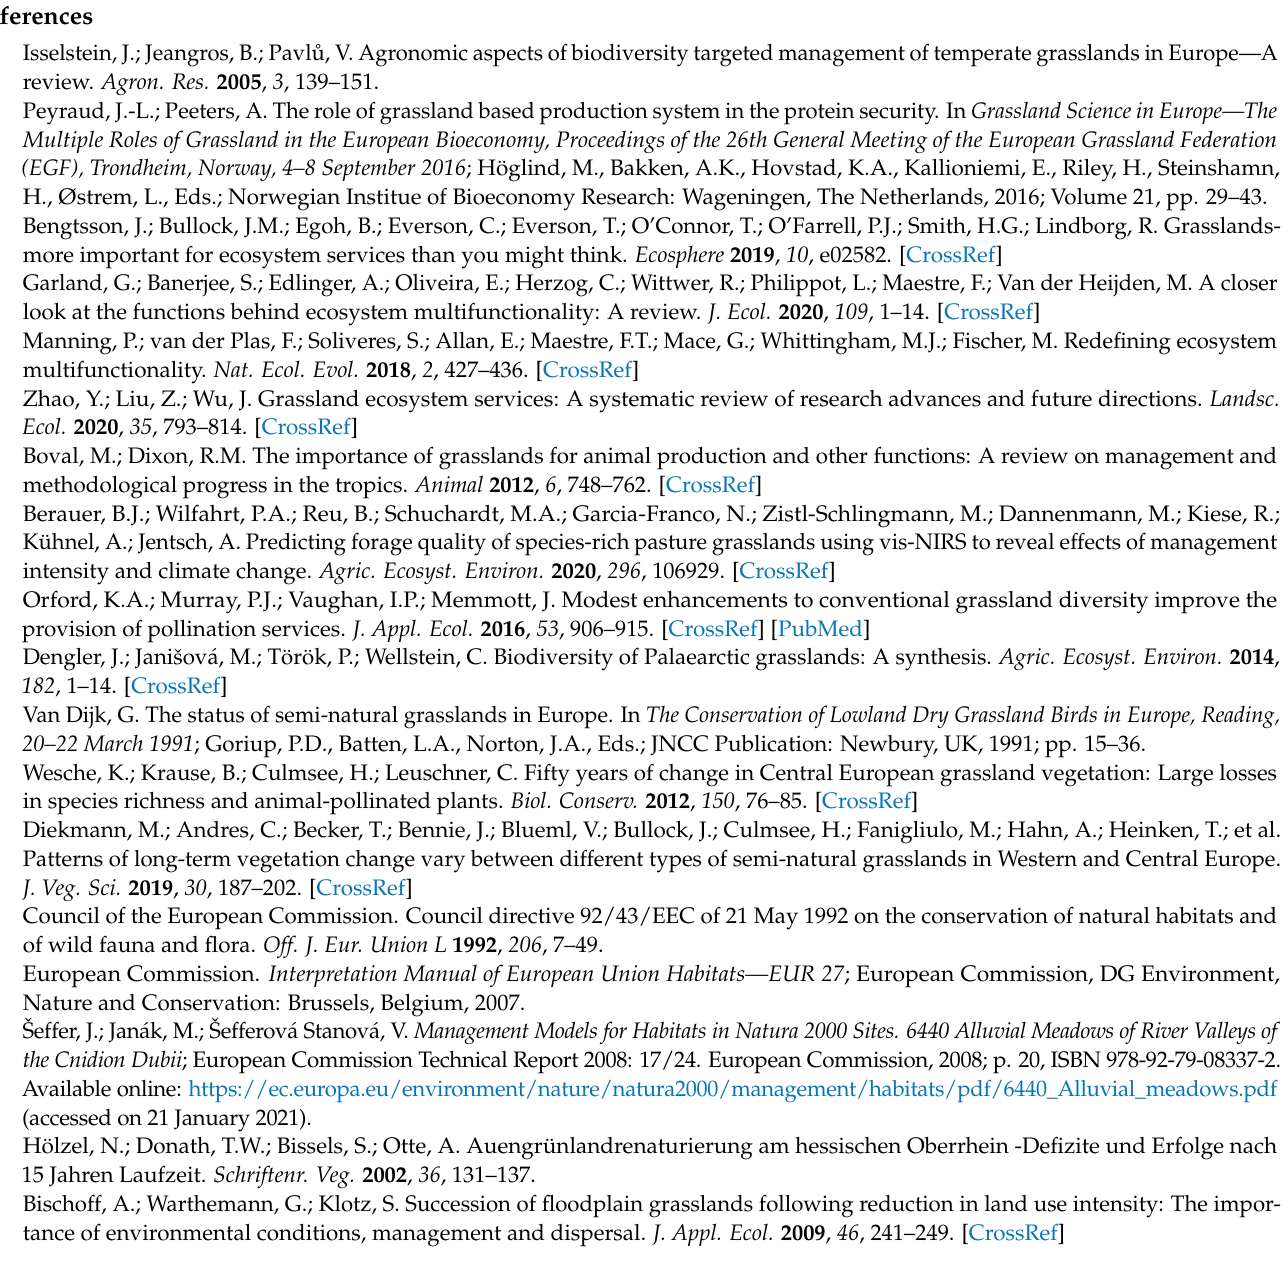
Figure A6. Development of percentage cover of the high-competitive target forbs Ranunculus acris and Selinum dubium with different fertilization treatments between 2010 and 2018 (except